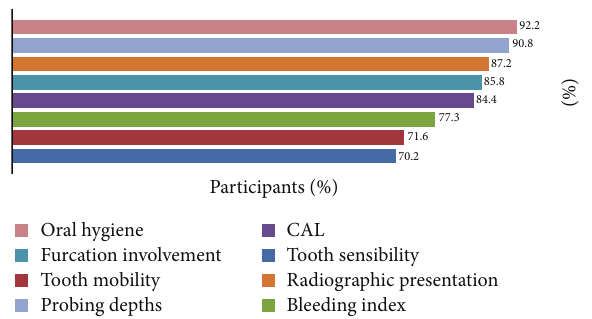
Figure 1: Participants’ responses: frequencies of the parameters routinely evaluated prior to and following periodontal regeneration procedures.